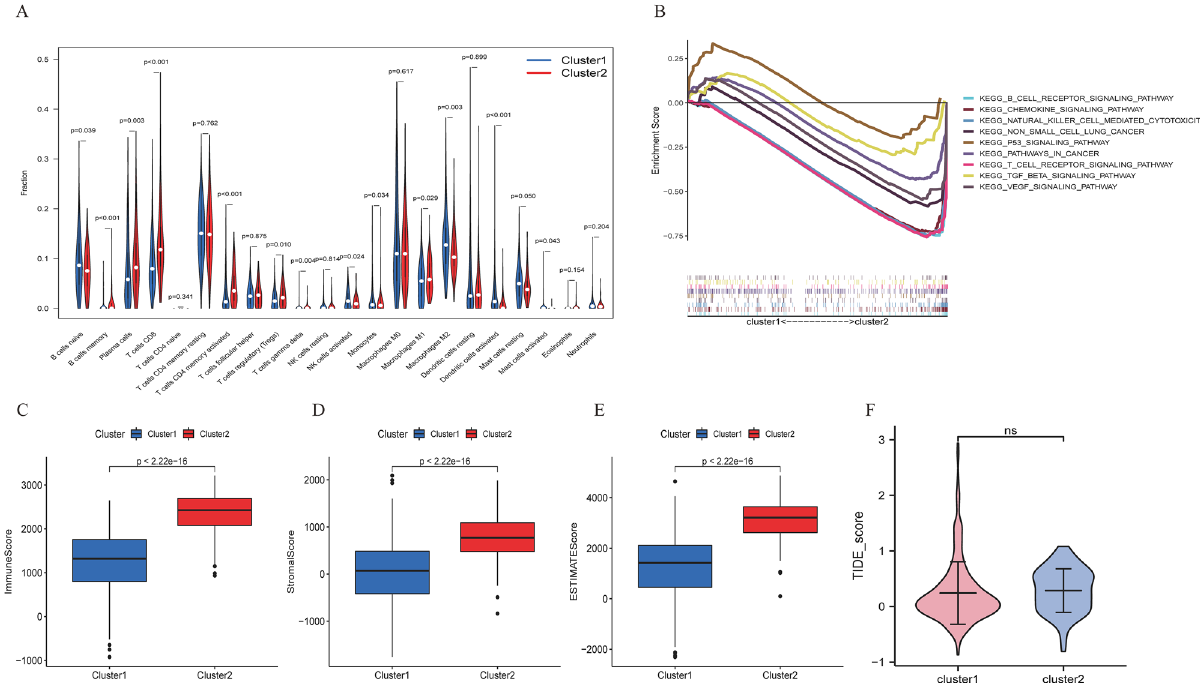
Figure 3. Identification of the immune cell infiltration landscape, tumour microenvironment score, KEGG pathway, and TIDE score in the two clusters. ( A ) The difference in immune cell infiltration between Cluster 1 and Cluster 2. ( B ) KEGG pathway analysis between Cluster 1 and Cluster 2. ( C – E ) ImmuneScore, StromalScore and ESTIMATEScore between Cluster 1 and Cluster 2. ( F ) The difference in TIDE_score between the two